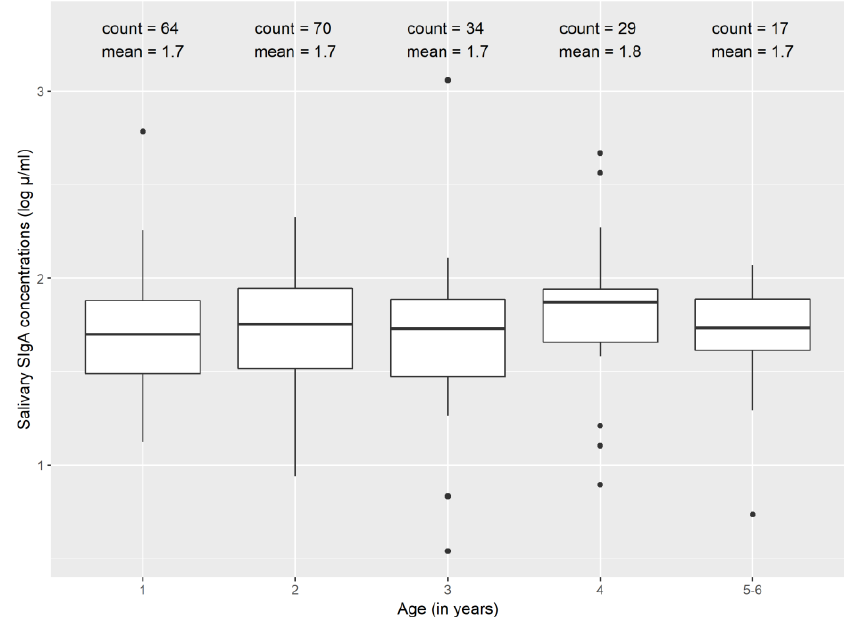
Figure 1. Salivary secretory immunoglobulin A (SIgA) concentrations (log µ g / mL) by age.